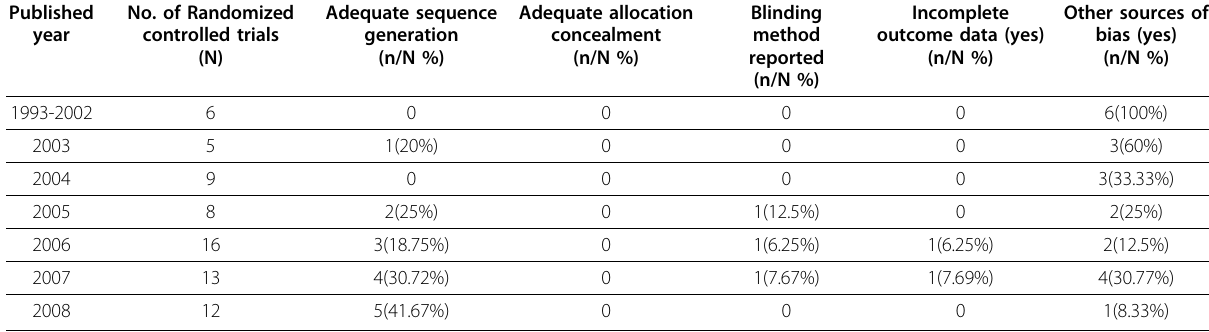
Table 1 Reporting of five quality components in randomized clinical trials on cupping therapy Published No. of Randomized year controlled